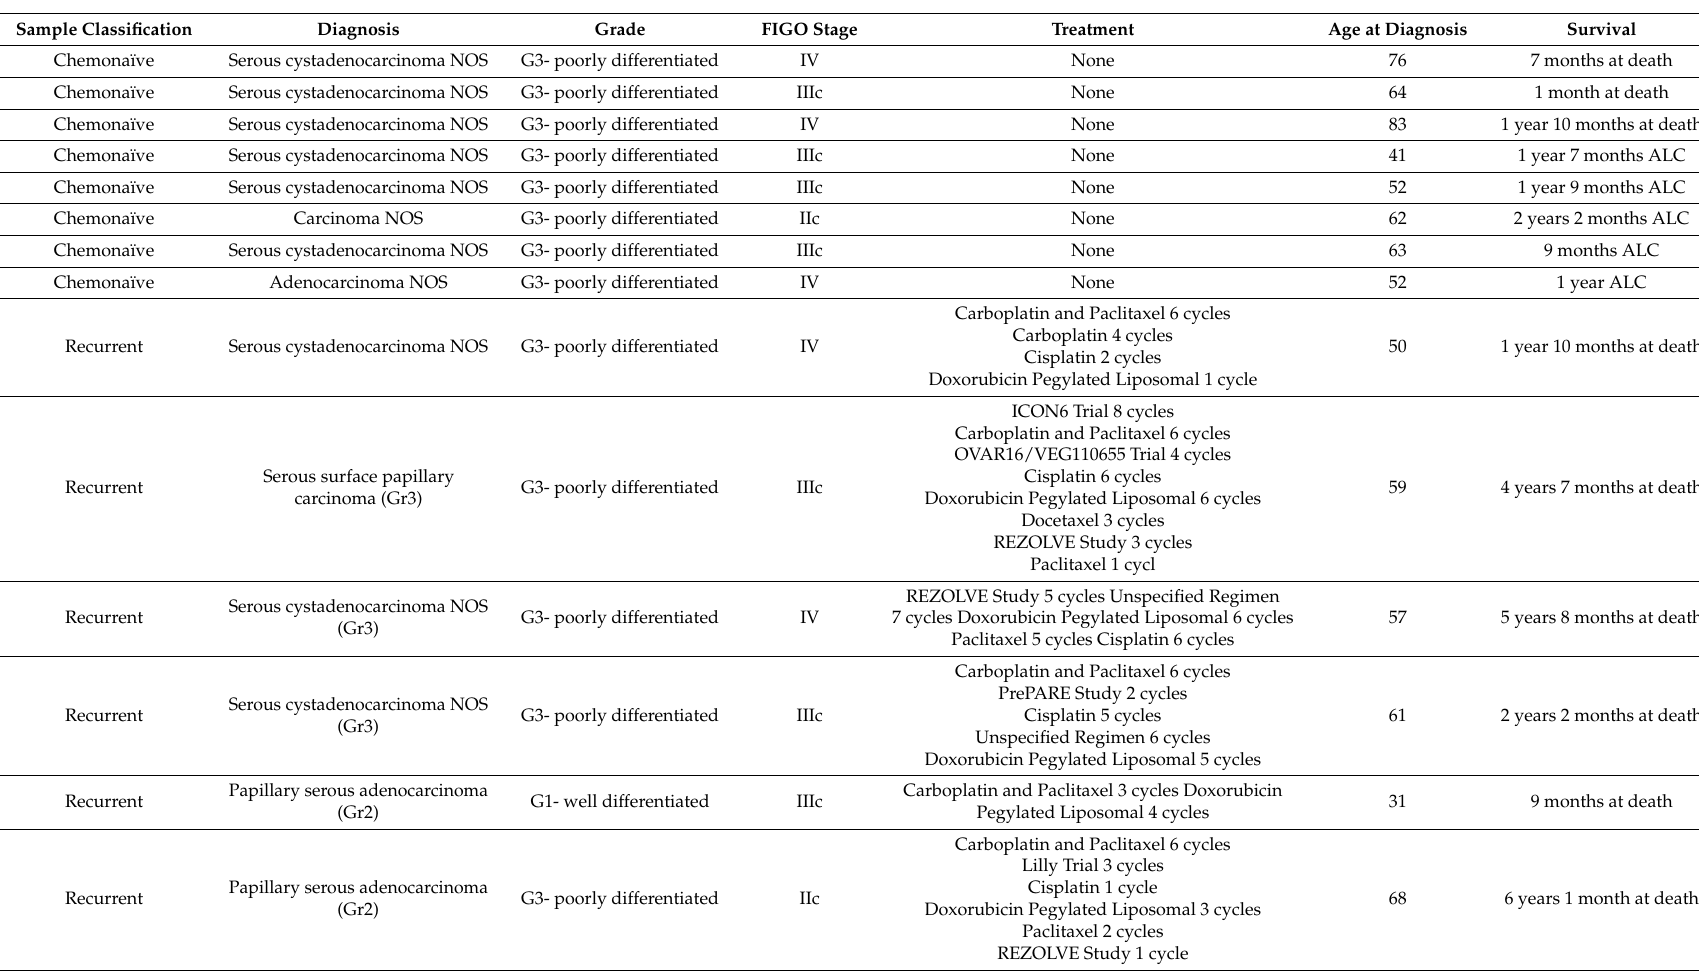
Table 2. Description of chemonaïve and recurrent patients recruited for the collection of ascites-derived tumour cells. Sample